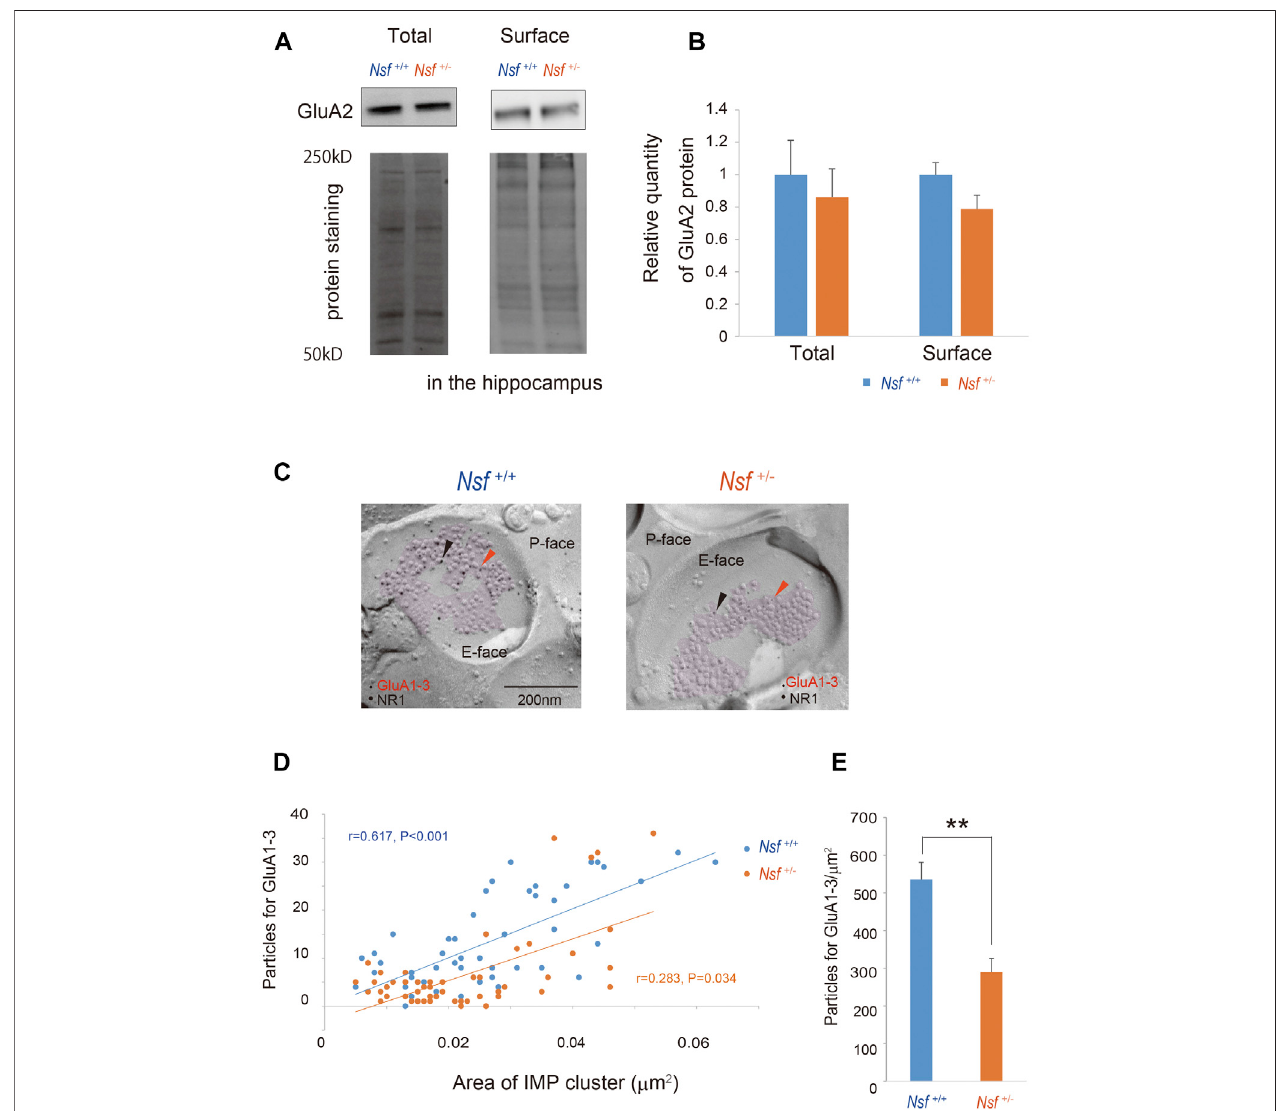
antibody.Stain-Free gelswereactivatedbyUVexposureandimagedusingaChemiDocTMMPimagerasaprotein loadingcontrol. (B) Relativebanddensities ofGluA2 were quanti fi ed using scanning densitometry. and normalized to protein loading control Results are expressed as a ratio of Nsf +/+ mice expression, resulting in a Nsf +/+ mice ratio of 1. ( n (cid:1) 4 for each genotype, mean ± SEM. Student ’ s t-test). (C) Replicas were prepared from the hippocampal CA1 region. Using a transmission electron microscope, postsynaptic membrane specializations of excitatory synapses in replicas were identi fi ed in the exoplasmic (E)-face of the plasma membrane by clusters of intra-membrane particles (IMP clusters, purple). Immunoreactivity for GluA1-3 was visualized with 5 nm immunogold particles (orange arrowheads). Immunolabeling for the NR1 subunit was visualized with 10 nm immunogold particles (black arrowheads) to con fi rm the IMP cluster areas. (D) The numbers of immunoparticlesforGluA1-3inindividualIMPclusterswereplottedagainsttheIMPclusterareas.CorrelationbetweentheGluA1-3labelingnumberandsynapticareain miceofeachgenotype(Spearman ’ srank-order test: the Nsf +/+ mice, n (cid:1) 56synapses, r (cid:1) 0.617, p < 0.001;the Nsf +/ − mice, n (cid:1) 56synapses, r (cid:1) 0.283,* p (cid:1) 0.034).